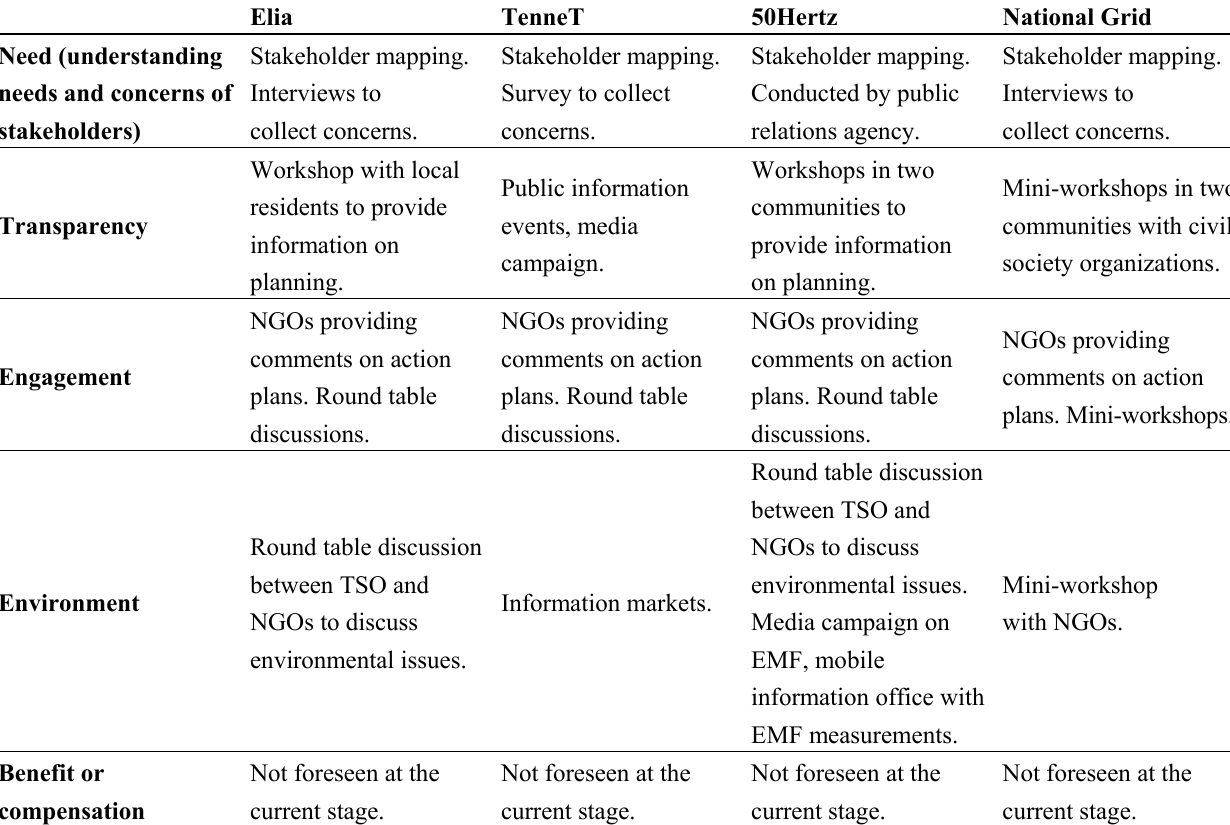
Table 1. Realization of the BESTGRID approach in four pilot